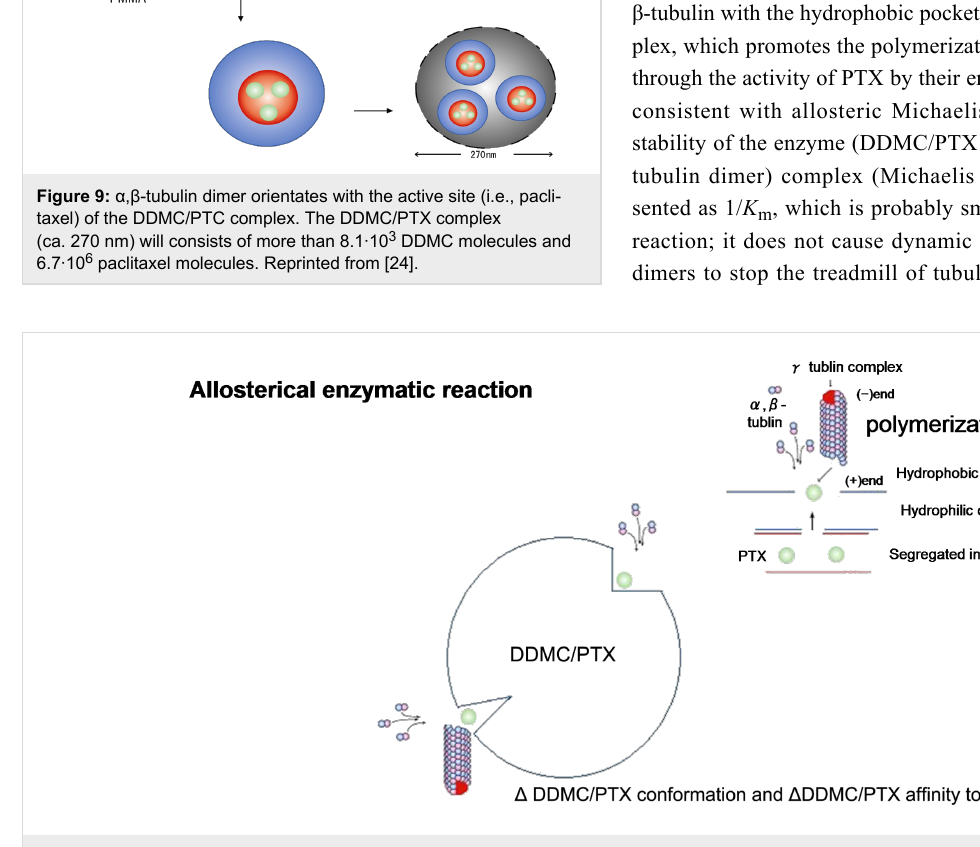
Figure 10: Schematic representation of α , β -tubulin dimer polymerization showing the allosteric relationship between the DDMC/PTX complex and α , β -tubulin. Simplified structures are shown. Reprinted from [62].